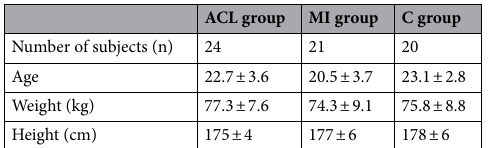
Table 1. Subjects characteristics. No significant difference was found for any